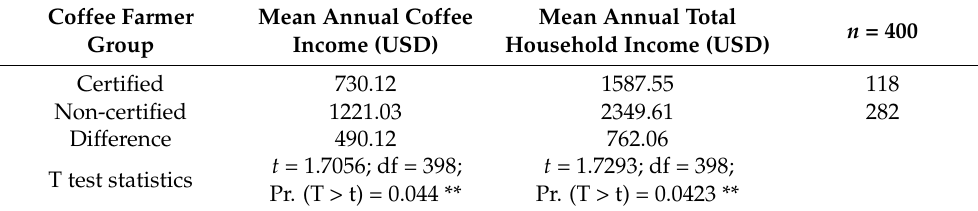
Table 7. Annual income differences between certified and non-certified farmers. Coffee Farmer